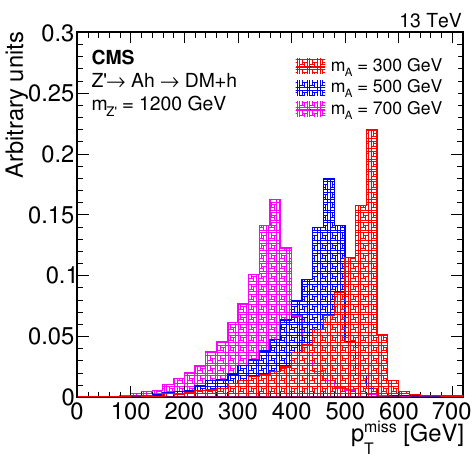
Figure 2 . Distribution of p miss at generator level for Z 0 ! A h ! DM+h with m A = 300, 500, T and 700 GeV with m Z 0 = 1200 GeV. All other parameters of the model are (cid:12)xed, as mentioned in the